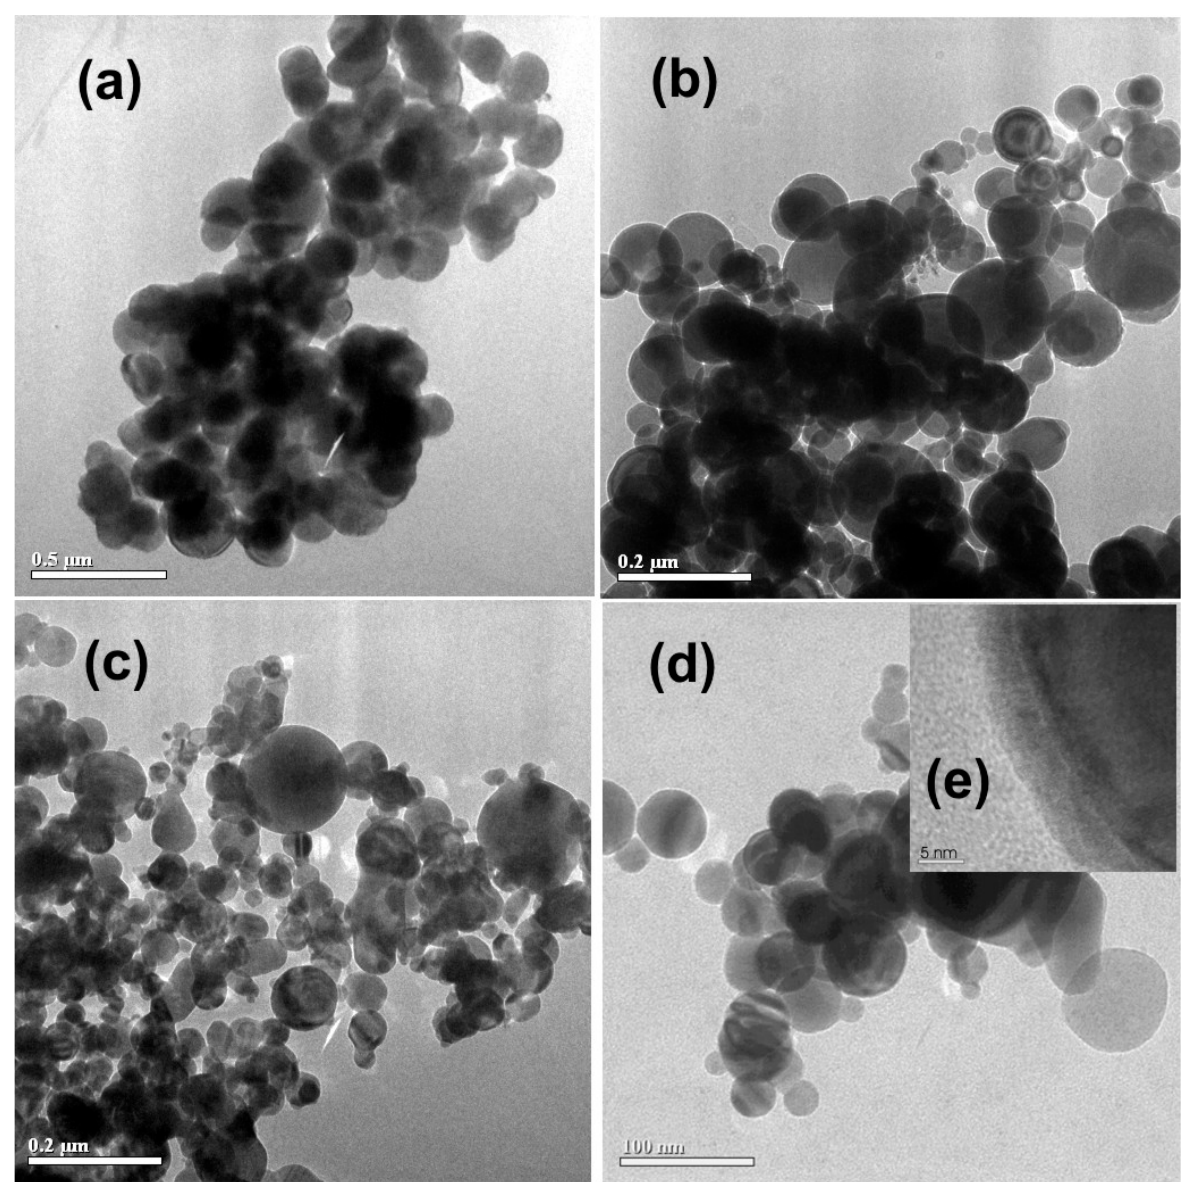
Figure 1. TEM microphotographs of magnetic particles: ( a )—magnetite (Fe 3 O 4 ); ( b )—metallic iron (Fe); ( c )—metallic nickel (Ni); ( d )—nickel particles coated with carbon shell (Ni@C); ( e )—HRTEM image of the carbon layer on the surface of Ni particle.